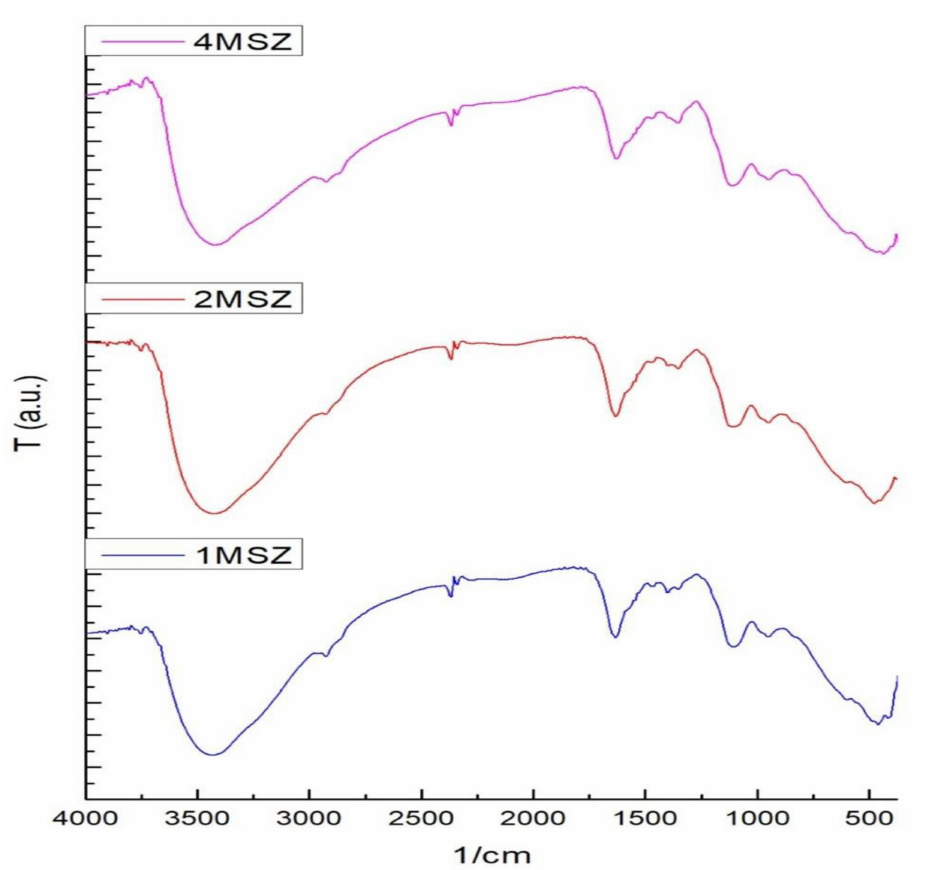
Figure 2. FT-IR spectrum of the as-synthesized MSZ samples in various MgO